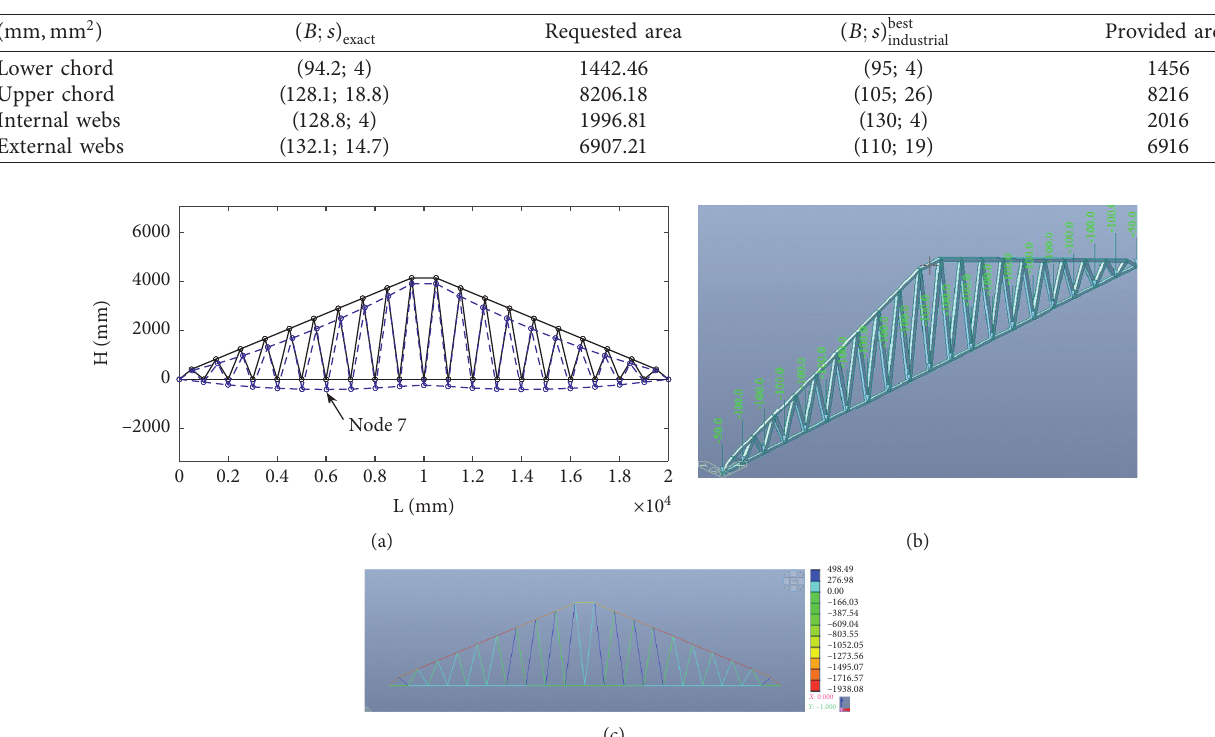
Table 6: Structural example 2: comparison between best exact solution and best industrial solution and relative requested and provided areas.